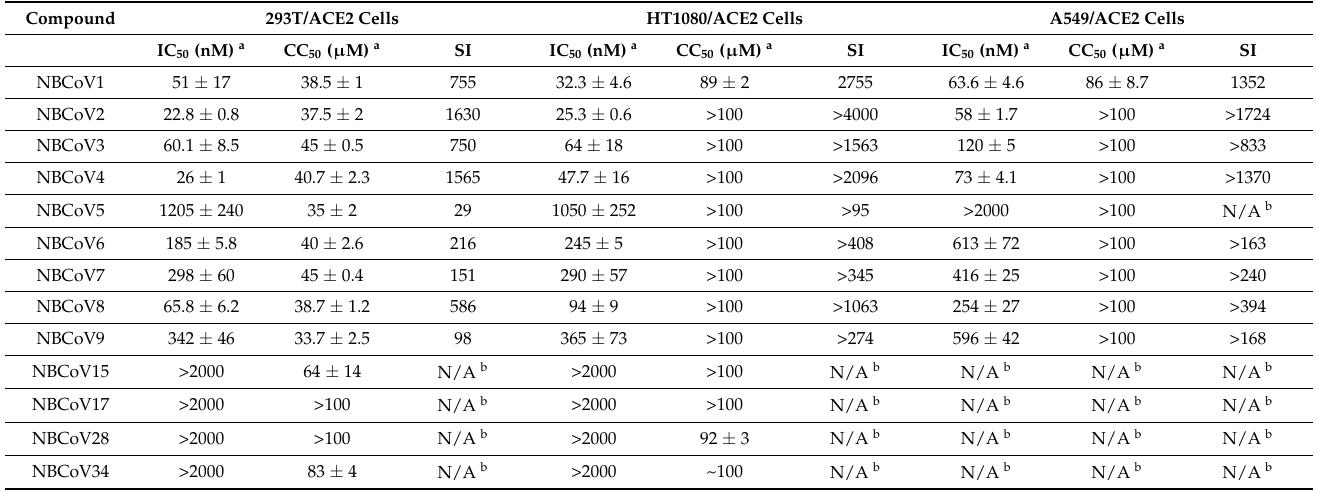
Table 1. Antiviral activity of the NBCoV small molecules in the single-cycle assay in different cell lines against pseudovirus NL4-3 ∆ Env-NanoLuc/SARS-CoV-2 (IC 50 ), toxicity (CC 50 ), and selectivity index